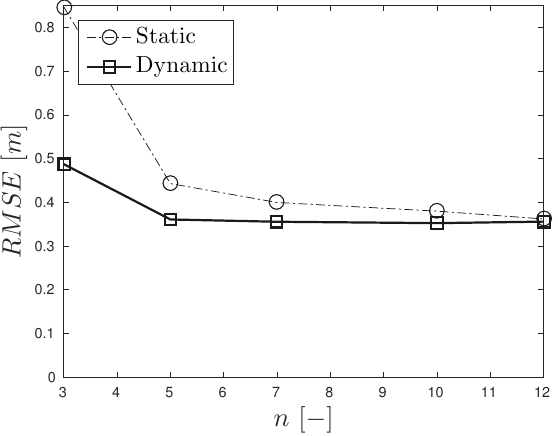
Figure 4. Root mean square error (RMSE) of the tracking error for the static (dash-dotted) and dynamic (solid) algorithms as a function of the number of